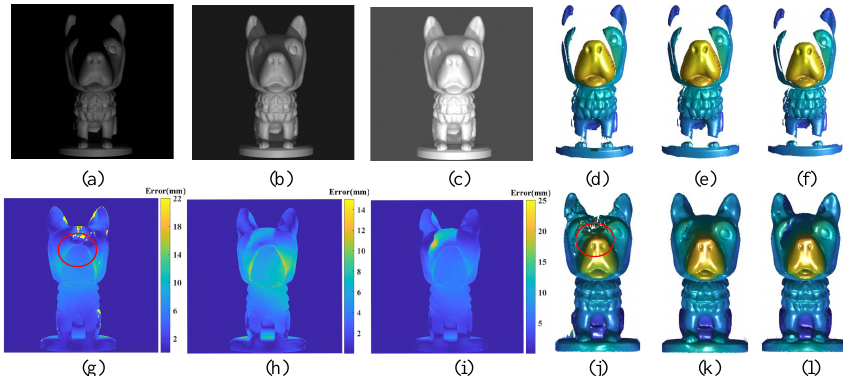
Figure 7. Predictions under different intensity levels of ambient light. ( a ) The texture image obtained without ambient light; ( b ) The texture image obtained with the same ambient light intensity as the training data; ( c ) The texture image obtained with strong ambient light to make it close to saturation; ( d – f ) 3D reconstructed geometries by using the FPP method for the three cases; ( g – i ) Absolute error maps for the three cases by comparing ground truths and the predicted depth maps, with RMSE 12.5076 mm, 4.7793 mm and 5.2146 mm, respectively; ( j – l ) 3D reconstructed geometries from the predicted depth maps for the three